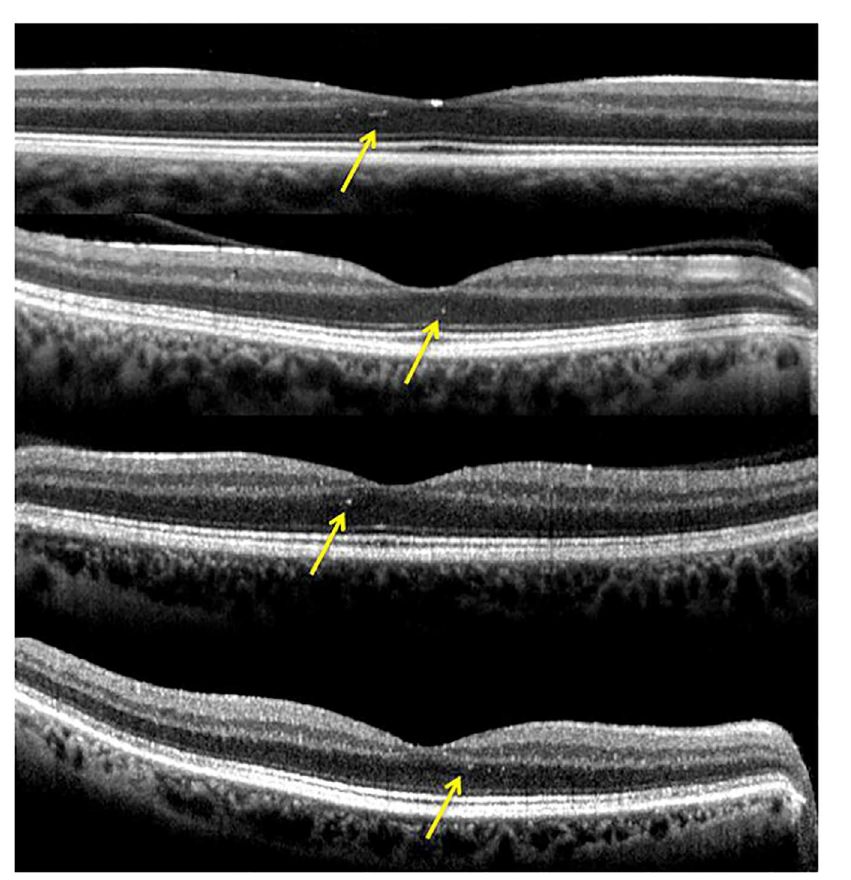
Fig 4. Hyperreflective dots in 4 of 11 ADOA patients at the level of the parafoveal ONL.